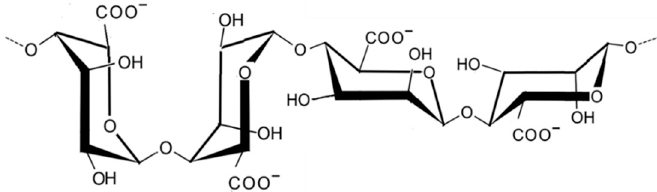
Figure 2. Idealized structue of the chemical units of alginic acid.